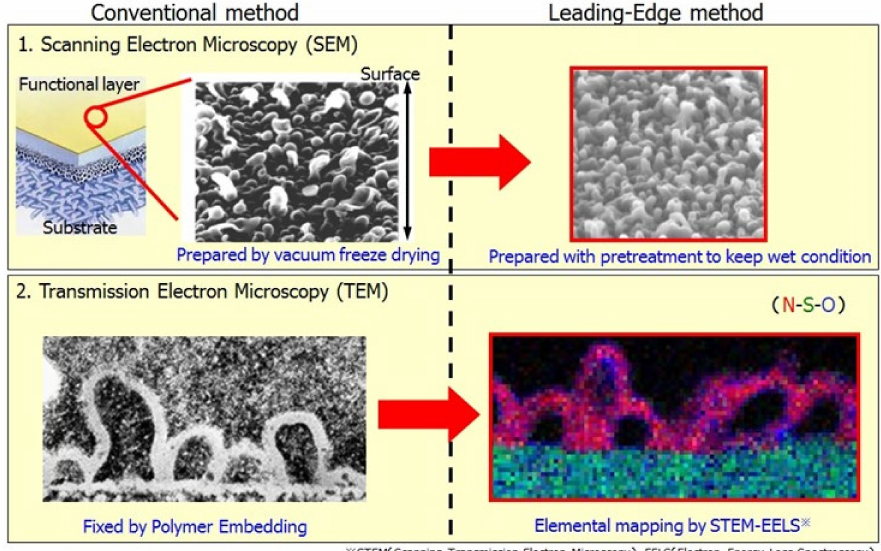
Figure 10. Precise structure of protuberance in “Mega-ton Water System” project